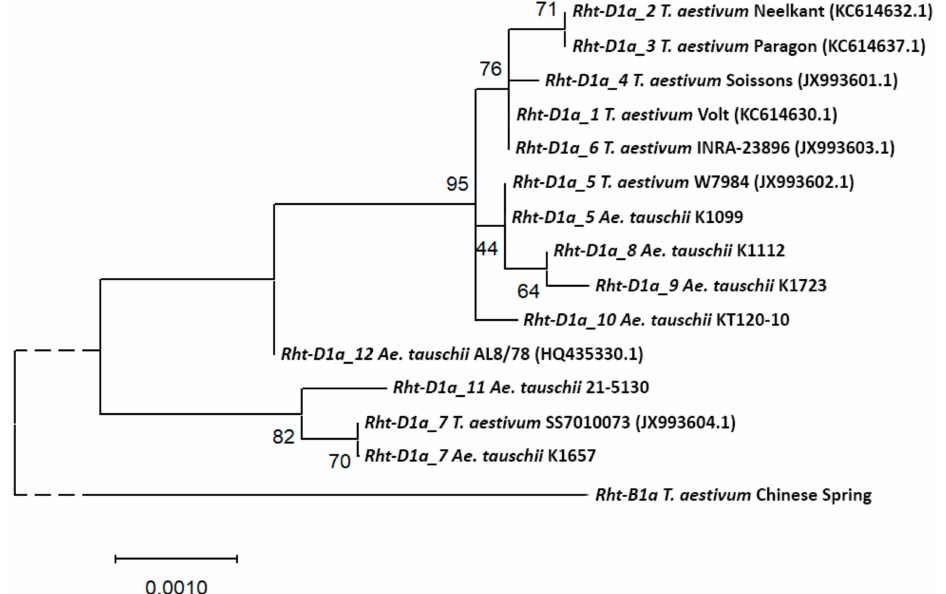
Figure 1. Molecular phylogenetic tree of the Rht-D1 gene alleles of Ae. tauschii and T. aestivum , constructed by the maximum-likelihood method. After the allele name, the catalog number of the Ae. tauschii accession or the wheat variety in which it was detected is indicated. The GenBank accession numbers for the nucleotide sequences are given in parentheses. The percentage of trees in which associated alleles clustered together in 500 bootstrap replicates is shown next to the branches. The Rht-B1 gene of common wheat was used as an